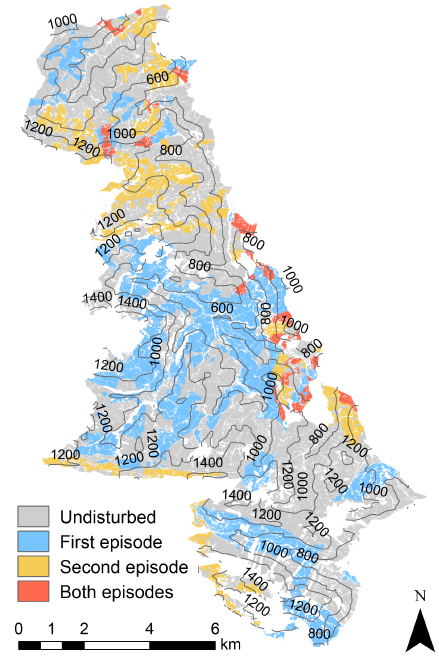
Figure 3. Disturbance activity in two episodes of natural distur- bance, from 1917–1923 (first episode) and 2007–2013 (second episode). Isolines represent elevational gradients (in